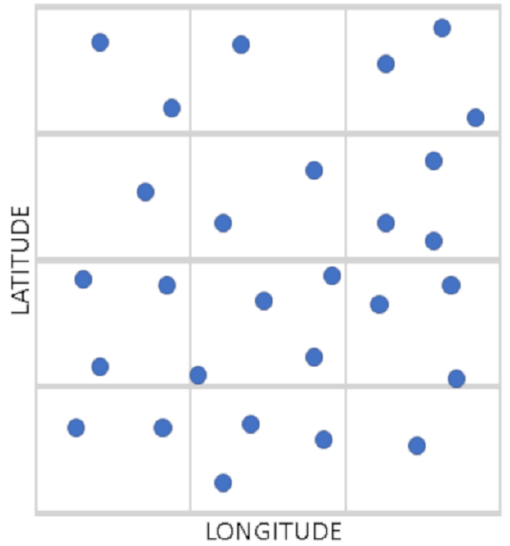
Figure 1. Blue dots represent GPM DPR measurements of σ °; horizontal and vertical lines are the latitude and longitude grid. The investigations in this paper are related to reducing the sample variance of estimates of mean σ ° at each latitude/longitude intersection point.